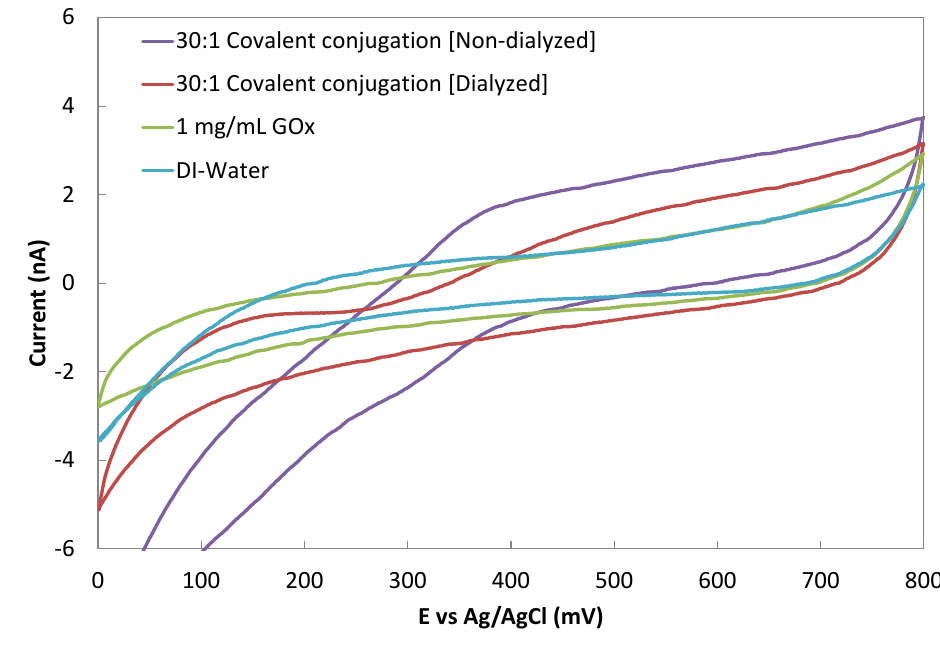
Figure 4. Cyclic voltammograms of GOx and FcCOOH-GOx covalent conjugates in DI-water at a scan rate of 50